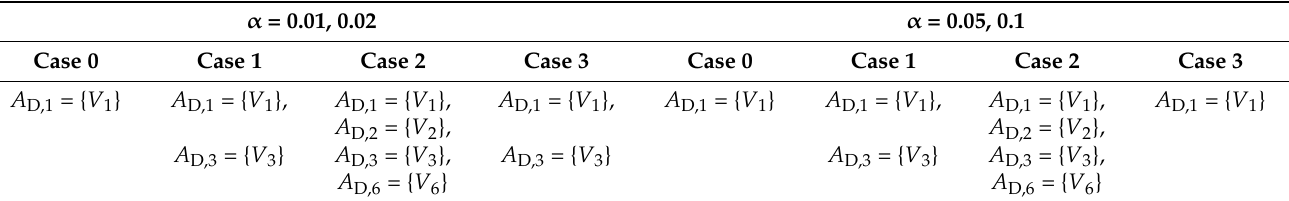
Table 21. One-Element Dominance Sets for Considered Study